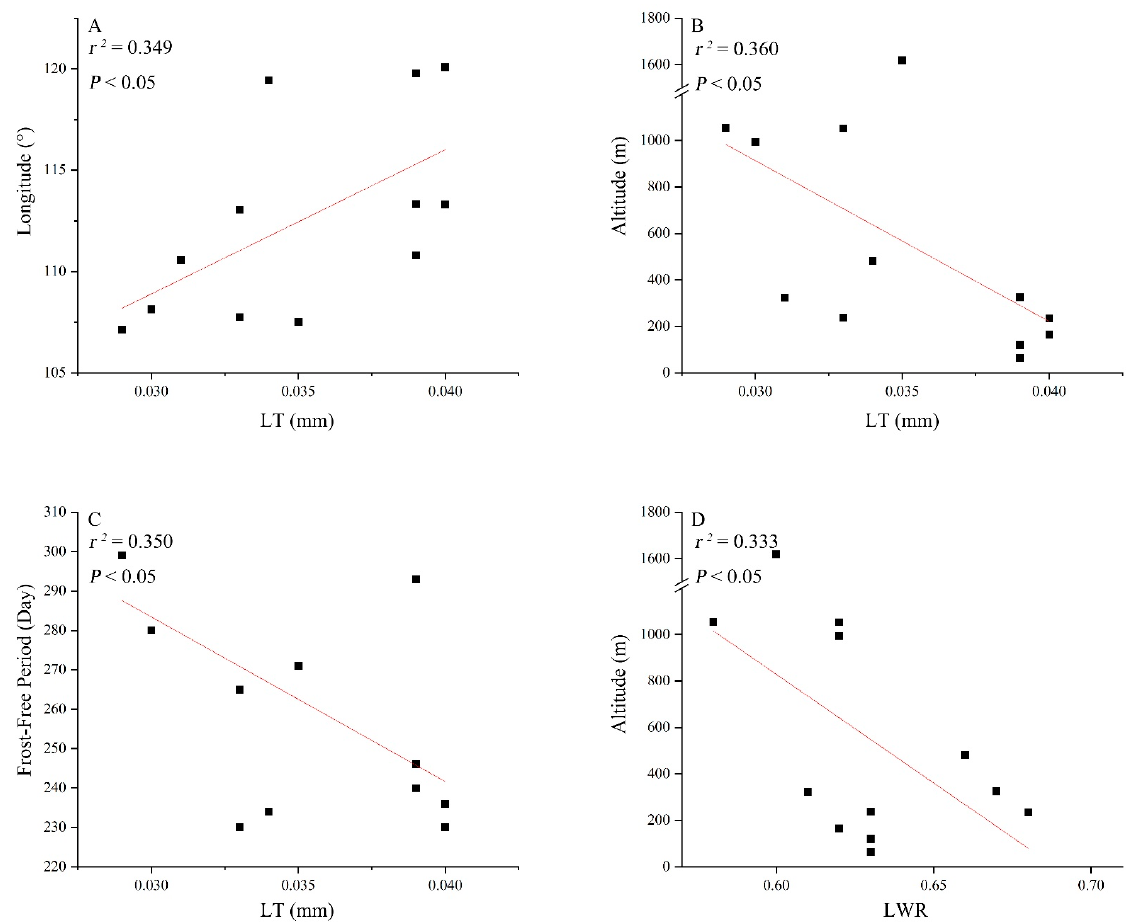
Figure 3. Significant correlations between LT and longitude (A), LT and altitude (B), LT and frost-